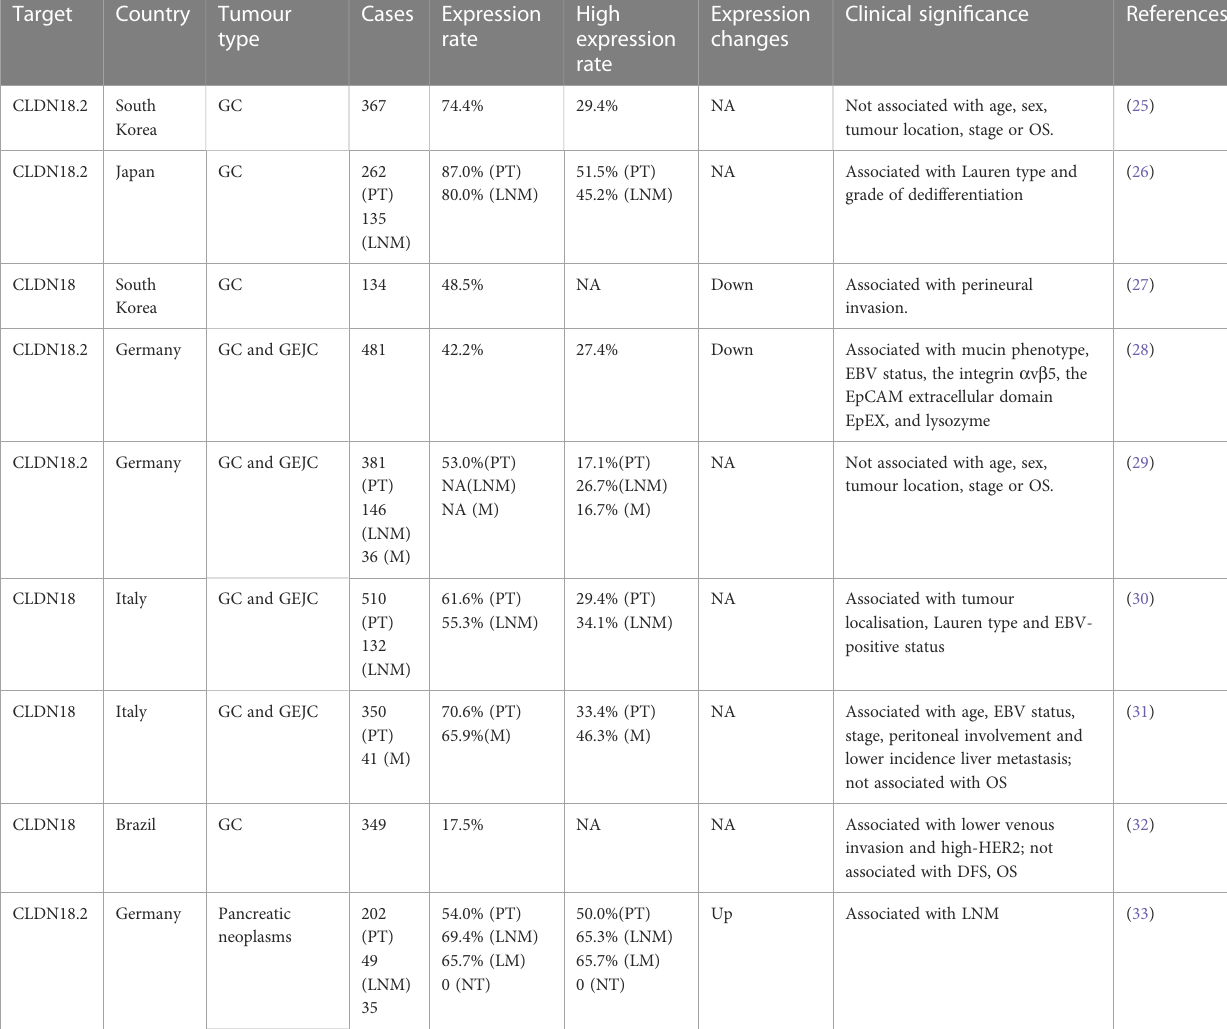
TABLE 1 The expression and clinical signi fi cance of CLDN18 in GI